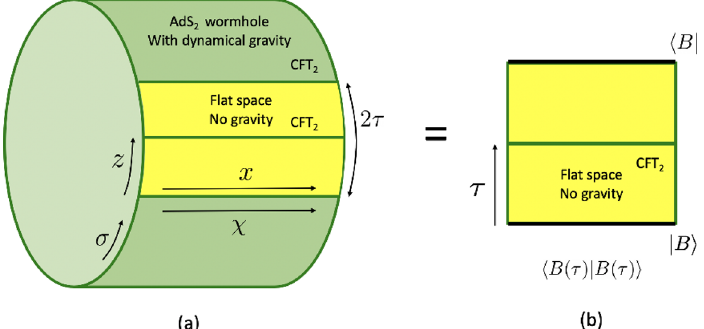
Figure 5 . (a) We consider a (green) wormhole geometry which connects two asymptotic boundaries, each of which is connected to the edges of a flat (yellow) strip. (b) In the dual description, we take the bra and the ket of the boundary state and compute the trace after doing some Euclidean